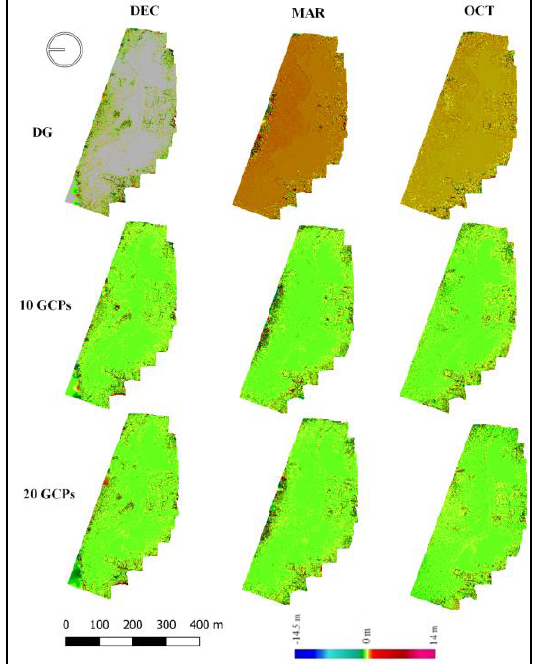
Figure 3. Representation of the scalar fields 2.5D DEM of Difference (DoD) obtained by superposition of DEM processed by traditional approach or using co-alignment.